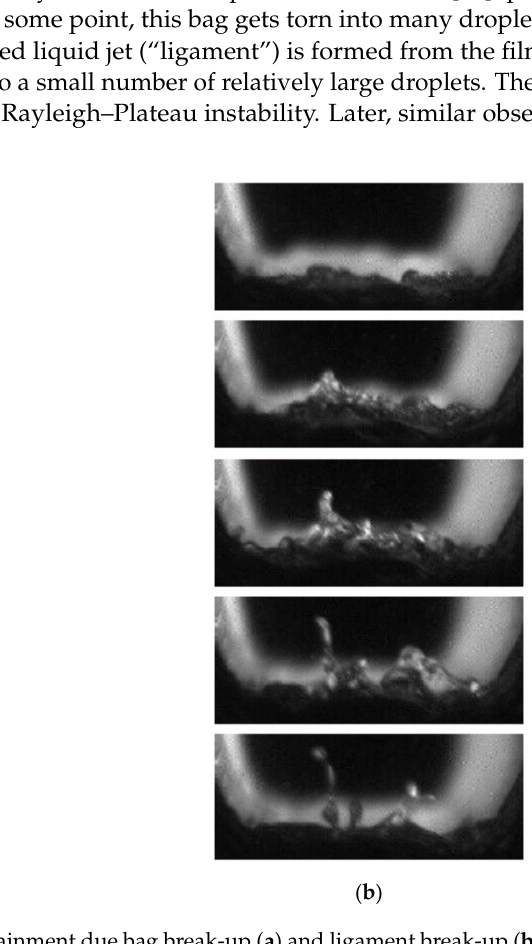
Figure 4. Visualization of entrainment due bag break-up ( a ) and ligament break-up ( b ) in a horizontal pipe in the y - z plane [42].